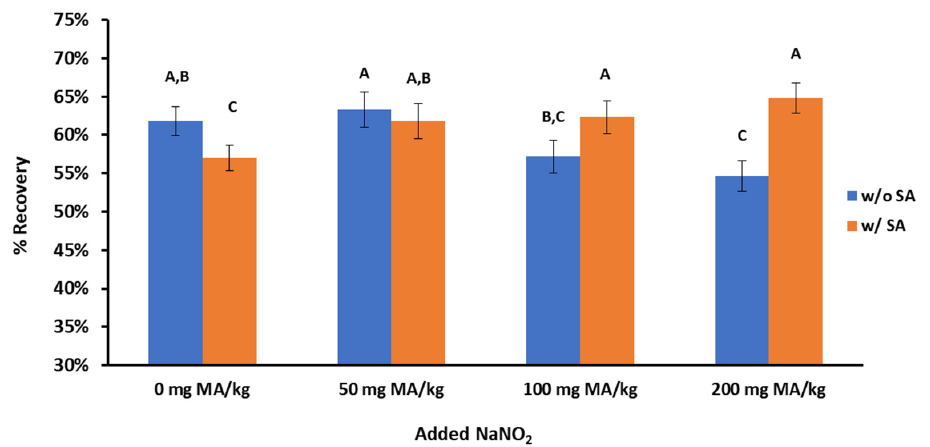
Figure 5. Recovery (%) of malonaldehyde for the steam distillation TBA method in the presence of NaNO 2 and sulfanilamide (SA). Different letters indicate statistically significant differences ( p < 0.05) among the eight treatments.